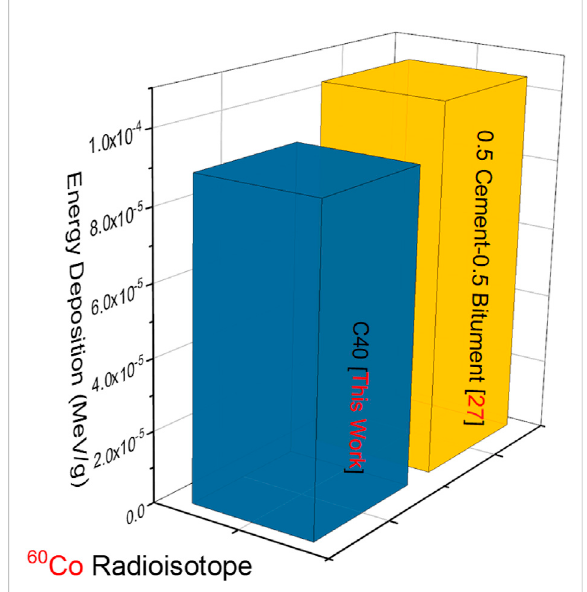
FIGURE 6 Variation of Energy Deposition (MeV/g) amounts in the air emitted from 60 Co.